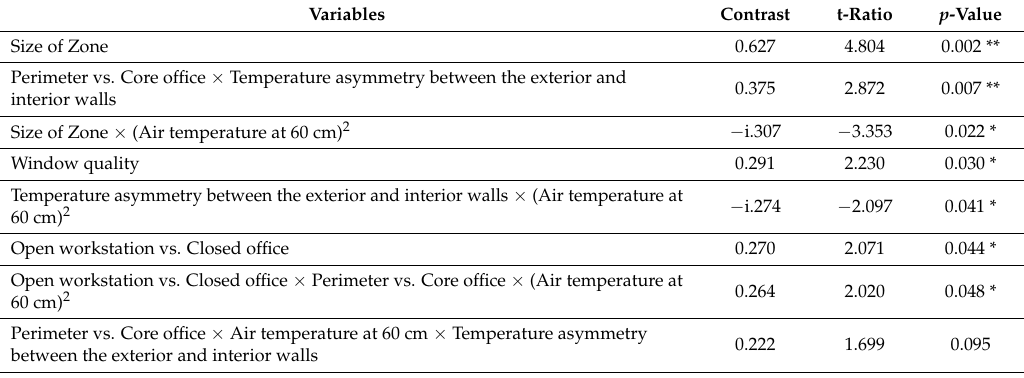
Table 16. Correlation of user satisfaction with the interaction of building attributes and IEQ measurements.